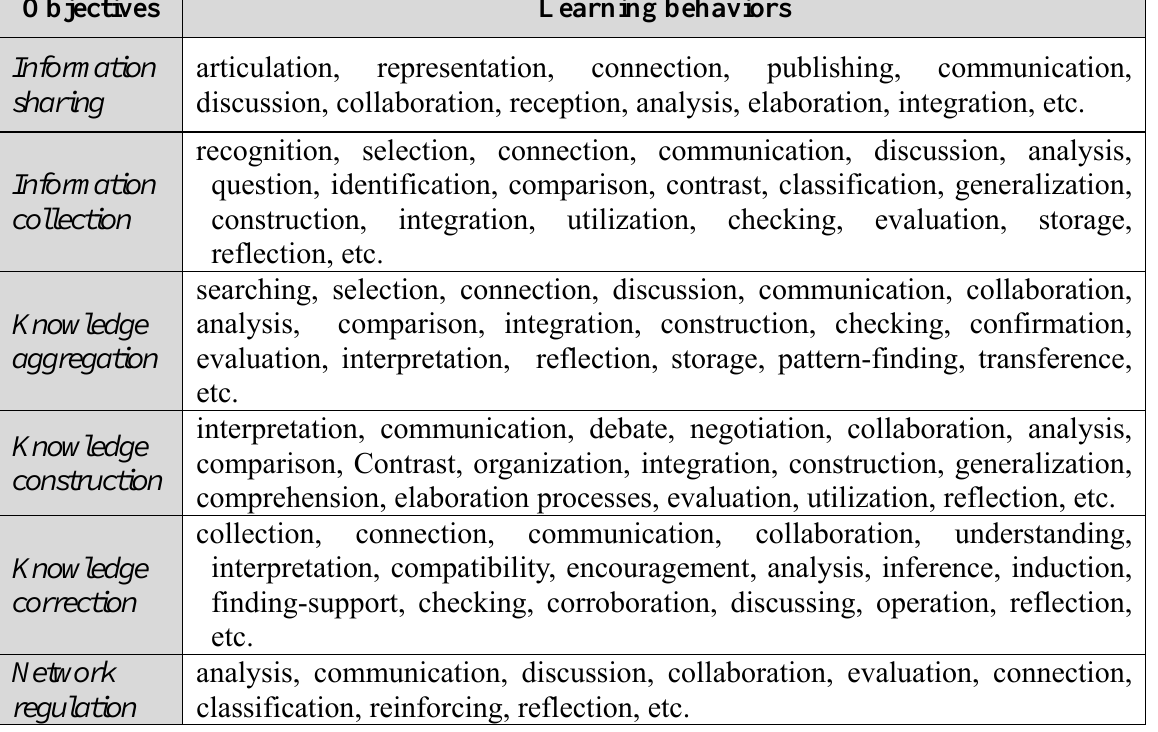
Table 2: Objectives and behaviors in utilizing the network resources